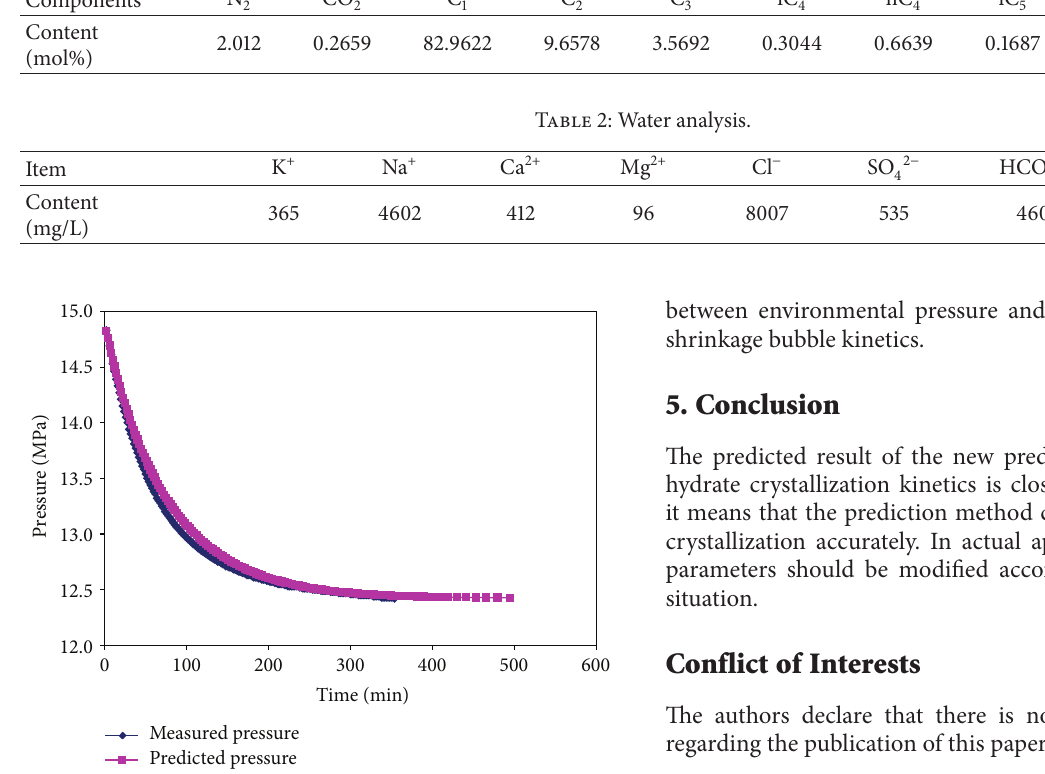
Figure 4: Comparison of the results of prediction method with